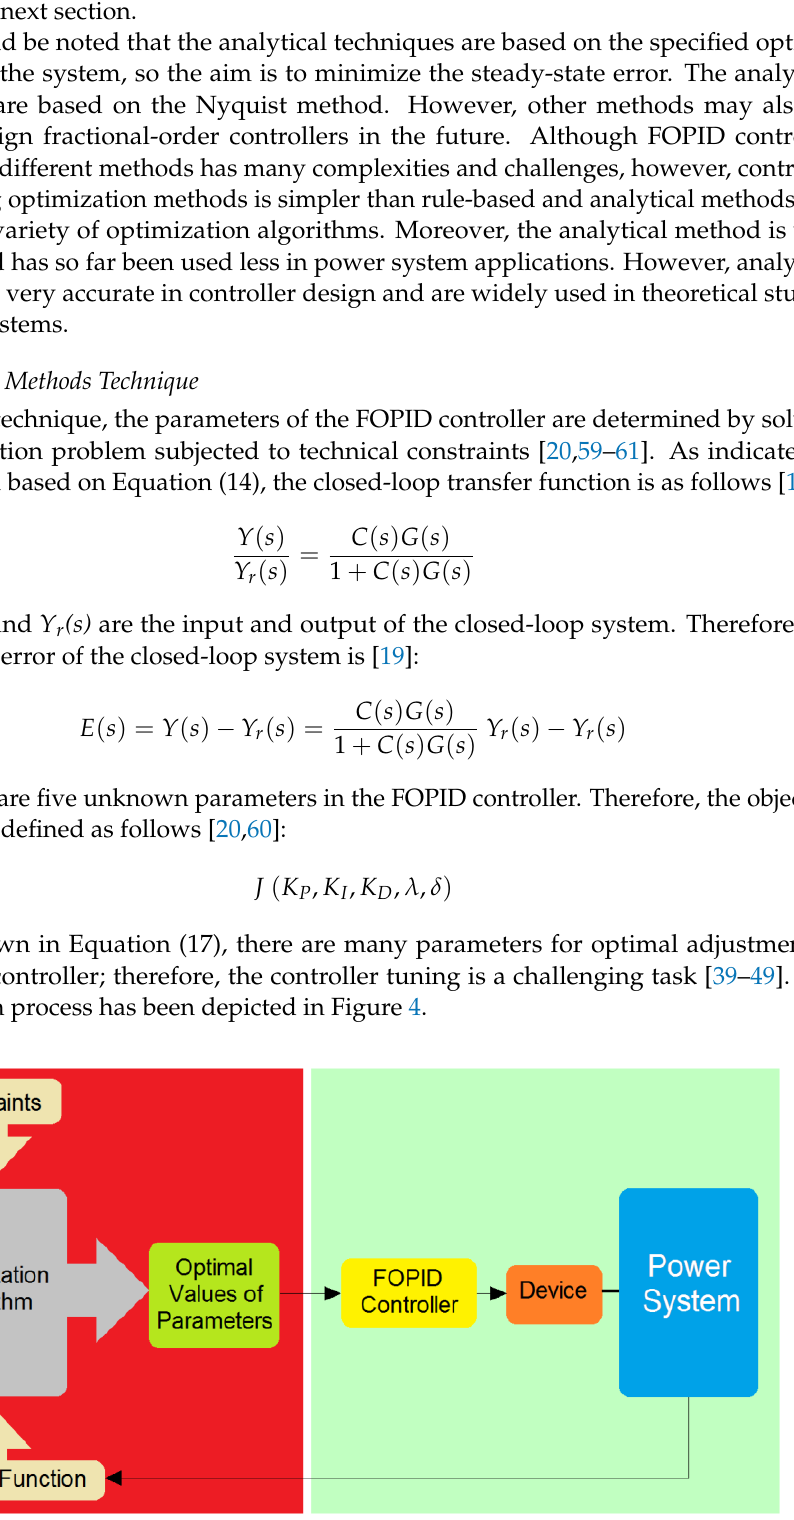
Figure 4. Optimization process for FOPID controller design.